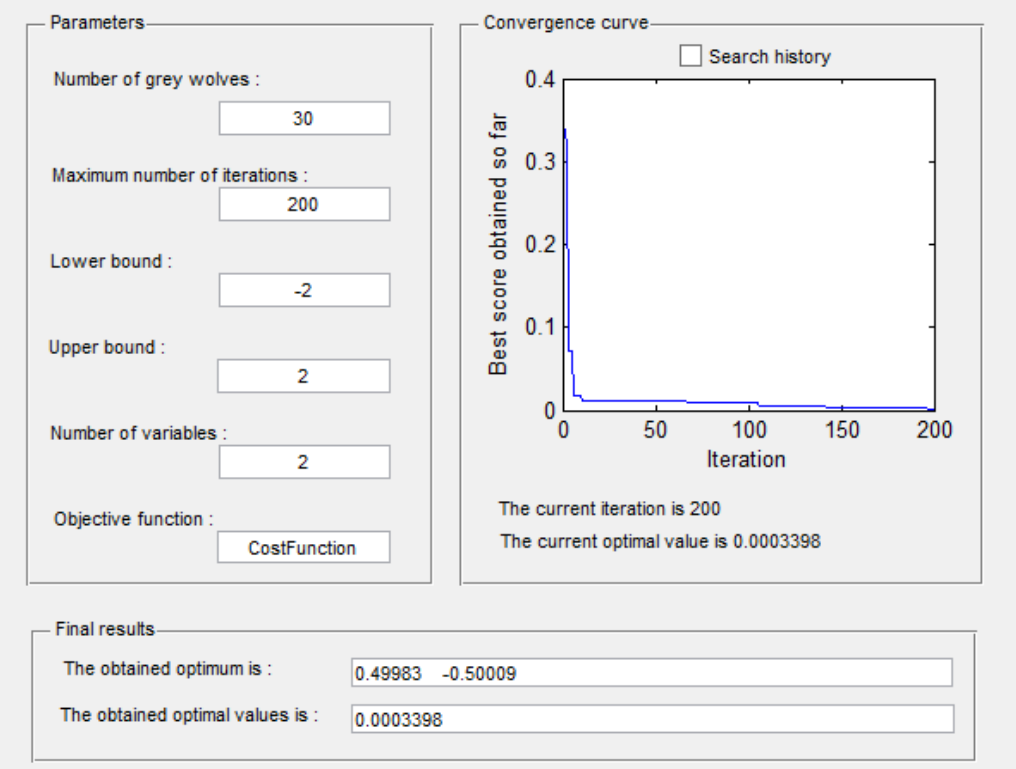
Figure 7. GWO search history for Problem